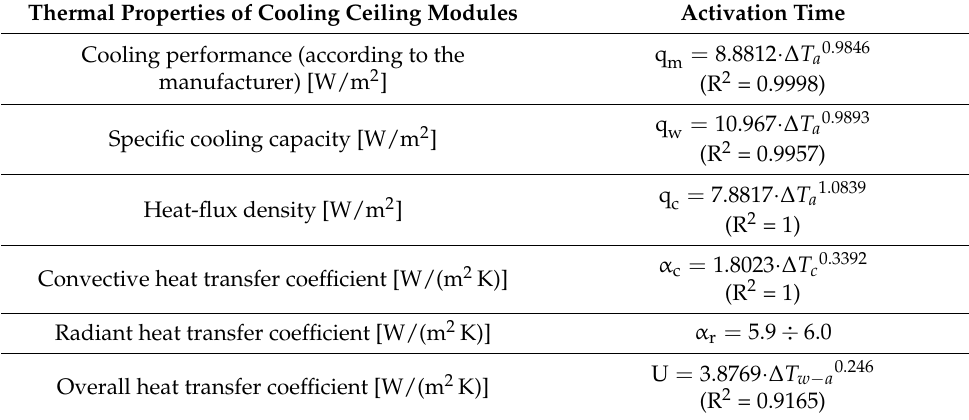
Table 1. Equations proposed for the calculation of thermal